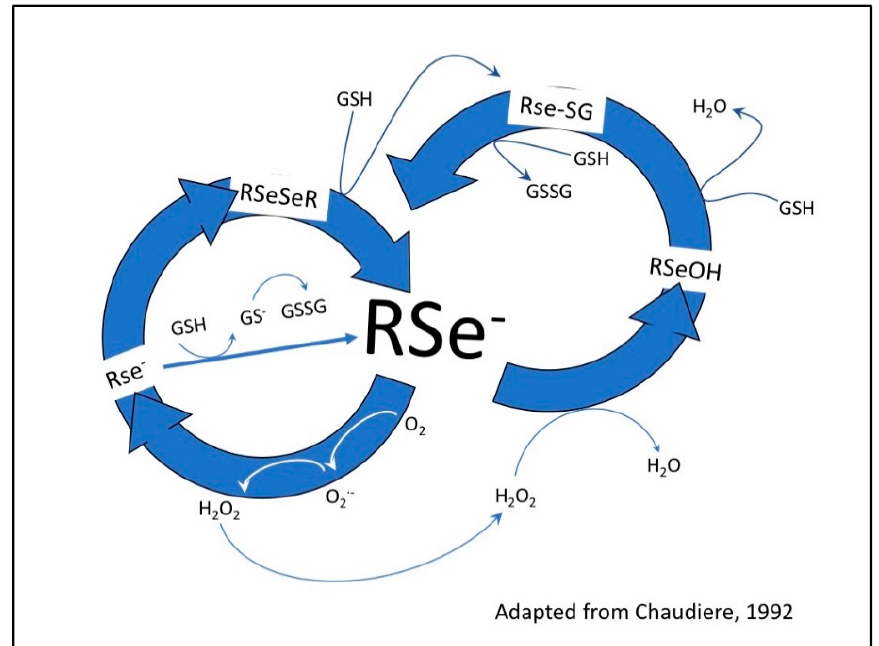
Figure 1. Redox cycling between selenium compounds and GSH. Glutathione (GSH) and other thiols reduce diselenides (RSeSeR) to selenenylsulfides (RSe-SG) and form the RSe − a catalytic species. The